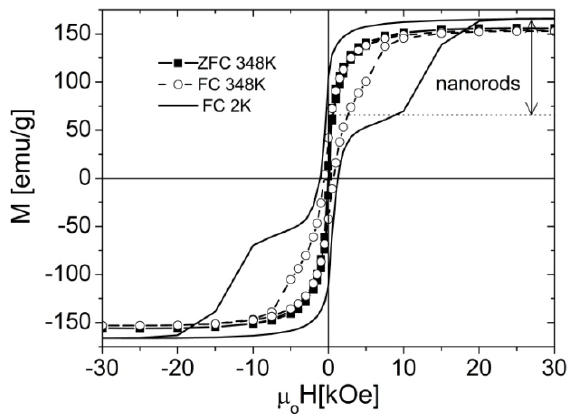
Figure 8. Hysteresis loops at 348 K after Zero field Cooling (ZFC) and at 348 K and 2 K after Field Cooling (FC, H = 3 T) for the sample obtained in situ with Boba:HDA:Co = 0.16:1:1 (sample showed in Figure 5(b)). The nanorods contribution to the total magnetization is indicated by an arrow.